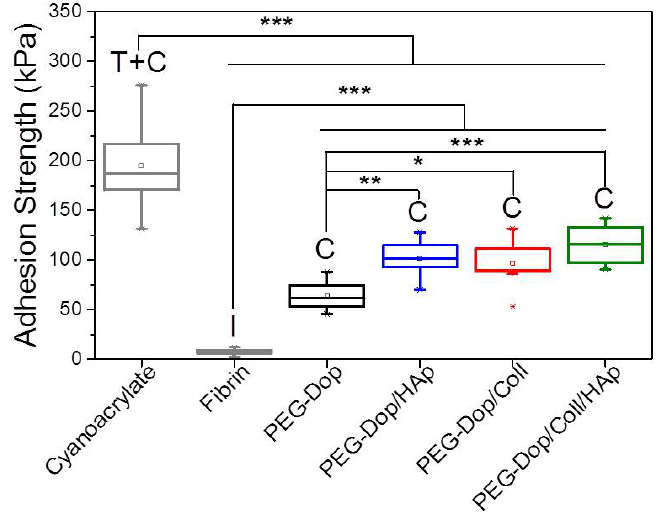
Figure 3. Adhesion strength values of PEG-Dop adhesives (15% ( w / v ) PEG-Dop, 2.5% ( w / v ) HAp, 0.1% ( w / v ) Coll), compared with commercial cyanoacrylate and fibrin glues on dry skin. Failure type: I, interfacial; C, cohesive; T + C, mixture of tissue and cohesive. * p < 0.05, ** p < 0.01, *** p < 0.001. Table 1. Tensile tests of PEG-Dop, PEG-Dop/Coll, composite hydrogel PEG-Dop/HAp and composite mixture